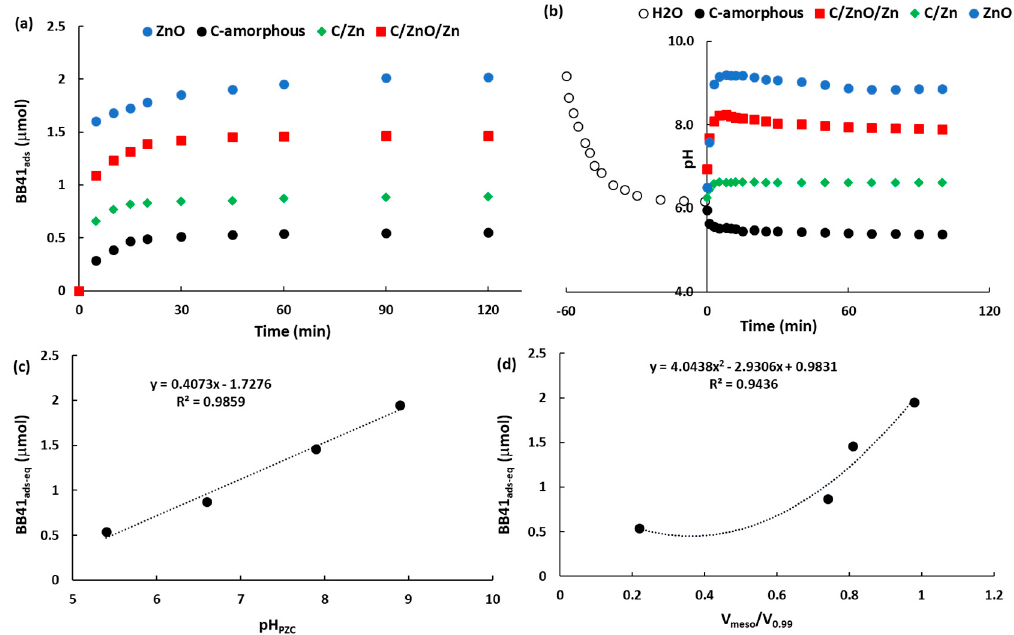
Figure 5. ( a ) Kinetics of BB41 adsorption in the dark; ( b ) pH changes as a function of time; ( c ) relationship between BB41 adsorbed and the pH PZC ; ( d ) relationship between BB41 adsorbed and the ratio V meso / V 0.99 . Table 3. List of kinetic results for the BB41 adsorption in the dark and pH PZC of the samples.